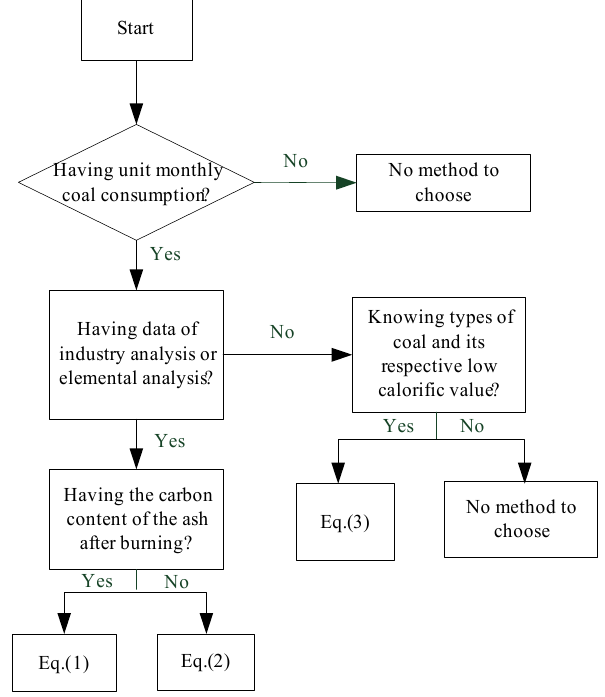
Figure 3. Calculation methods of coal combustion emissions under different conditions.